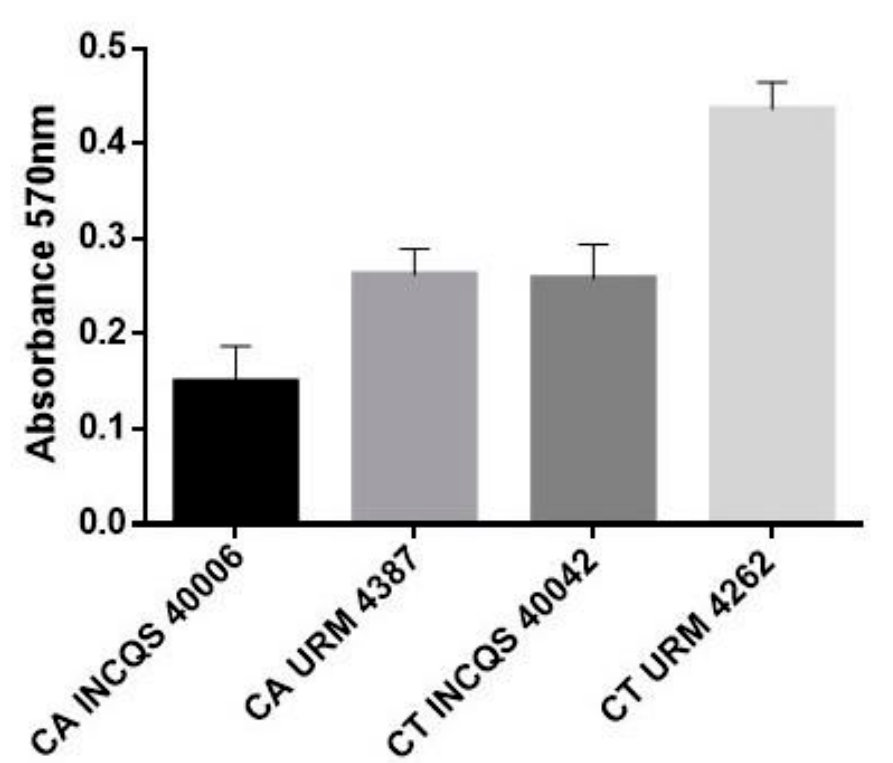
Figure 4. Biofilm formation by different Candida strains. The results are expressed as biofilm staining intensity read at 595 nm C. tropicalis INCQS 40042—moderate; C. albicans INCQS 40006; C. tropicalis URM 4262; C. albicans URM 4387. INCQS—National Institute for Quality Control in Health; URM— University Recife Mycology.